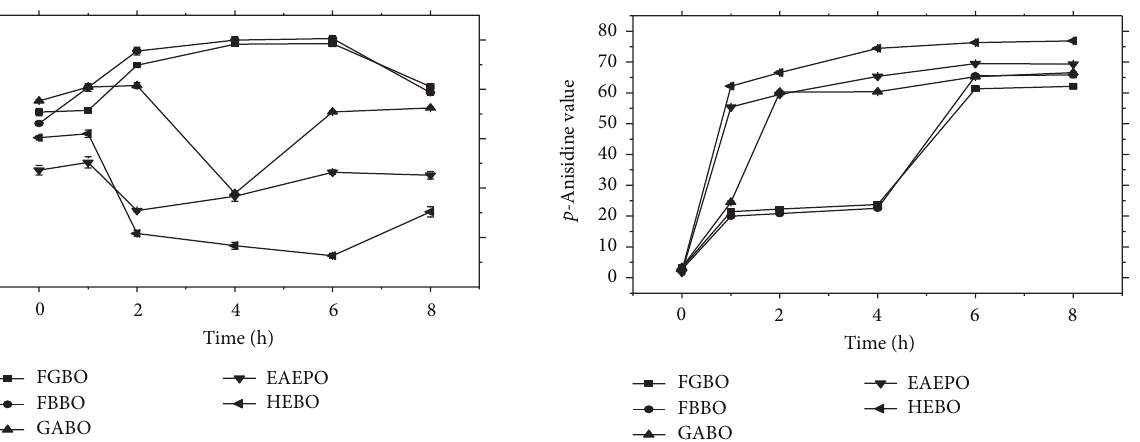
Figure 2: Changes in peroxide value. Figure 3: Changes in